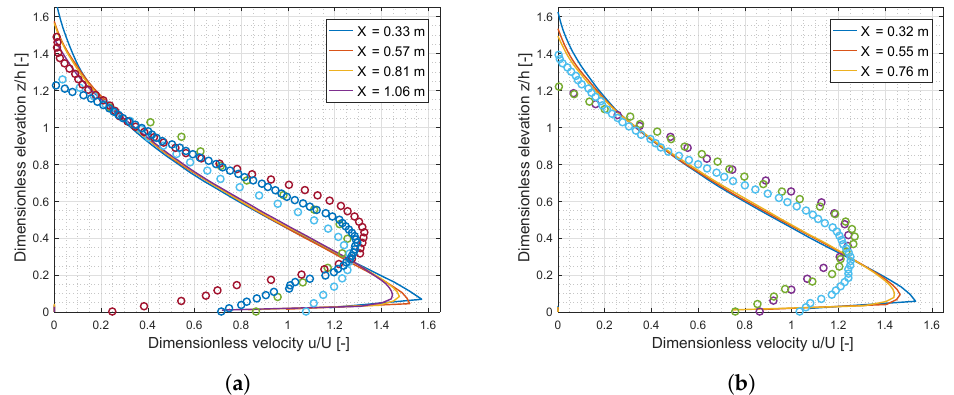
Figure 9. Comparison of numerical dimensionless velocity profiles (solid lines) versus experimental data (circles): ( a ) 64 ◦ breach face; ( b ) 70 ◦ breach face.